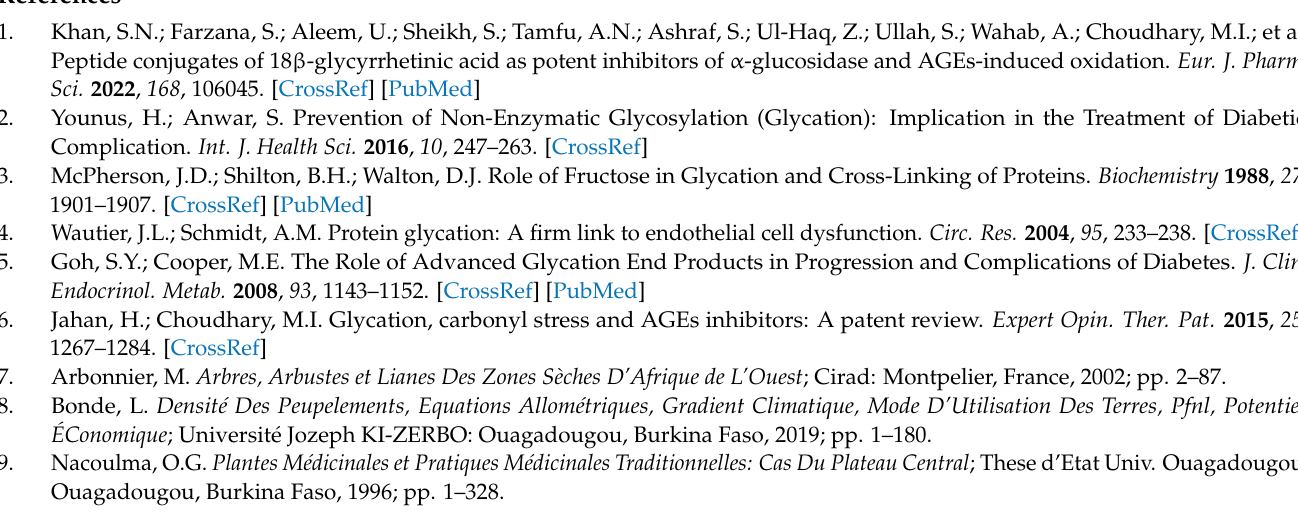
1 ; Figure S2: HRFABMS spectrum of compound 1 ; Figure S3: IR spectrum of compound 1 ; Figure S4: UV/UV–Visible (MeOH) spectrum of compound 1 ; Figure S5: 1 H NMR (400 MHz, CD 3 OD) spectrum of compound 1 ; Figure S6: 13 C NMR (101 MHz, CD 3 OD) spectrum of compound 1 ; Figure S7: FABMS spectrum of compound 2 ; Figure S8: HRFABMS spectrum of compound 2 ; Figure S9: IR spectrum of compound 2 ; Figure S10: UV/UV–Visible (MeOH) spectrum of compound 2 ; Figure S11: 1 H NMR (500 MHz, CD 3 OD) spectrum of compound 2 ; Figure S12: 13 C NMR (151 MHz, CD 3 OD) spectrum of compound 2 ; Figure S13: FABMS spectrum of compound 3 ; Figure S14: HRFABMS spectrum of compound 3 ; Figure S15: IR spectrum of compound 3 ; Figure S16: UV/UV-Visible (MeOH) spectrum of compound 3 ; Figure S17: 1 H NMR (400 MHz, CD 3 OD) spectrum of compound 3 ; Figure S18: 13 C NMR (201 MHz, CD 3 OD) spectrum of compound 3 ; Figure S19: FABMS spectrum of compound 4 ; Figure S20: UV/UV-Visible (MeOH) spectrum of compound 4 ; Figure S21: IR spectrum of compound 4 ; Figure S22: 1 H NMR (500 MHz, CD 3 OD) spectrum of compound 4 ; Figure S23: 13 C NMR (201 MHz, CD 3 OD) spectrum of compound 4 . Table S1: in vitro antiglycation activity: fluorescence analysis of M. inermis and T. indica plant